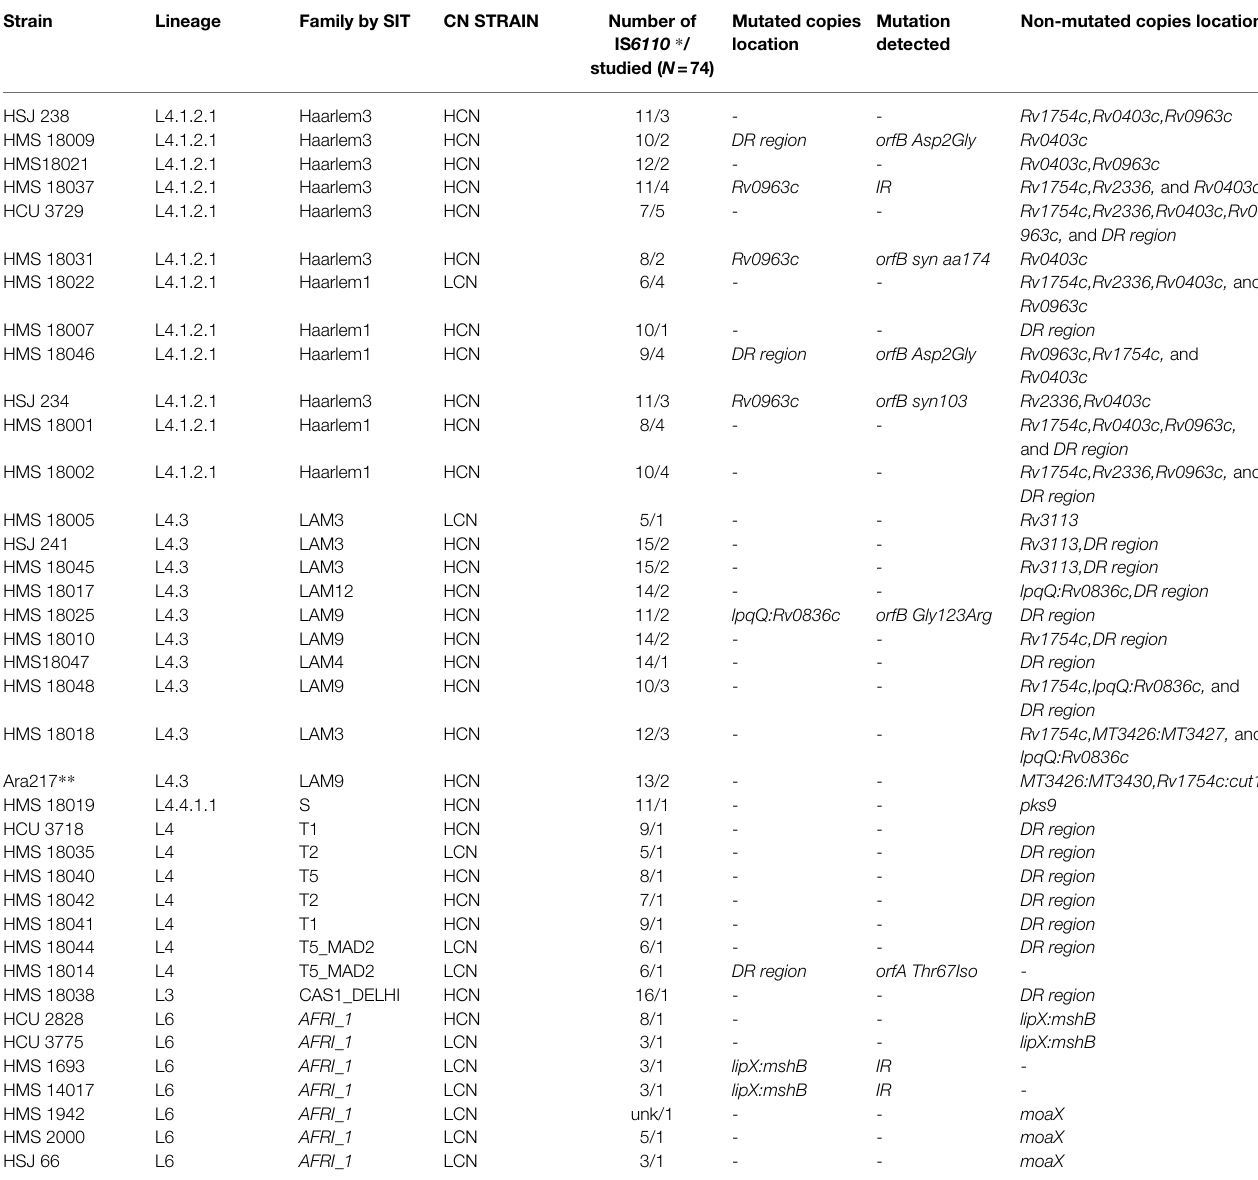
TABLE 2 | Summary of the IS 6110 sequences localised in preferential sites published for determined Mycobacterium tuberculosis families (Reyes et al., 2012; Comín et al., 2021). Strain Lineage Family by